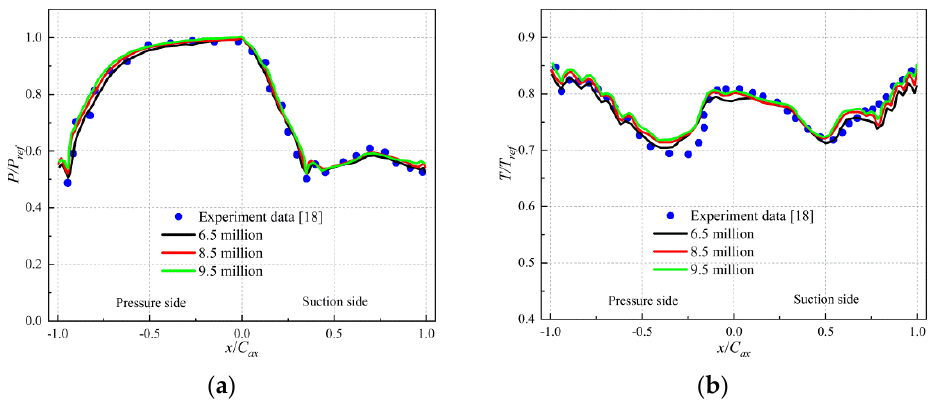
Figure 4. Grid independence test. ( a ) Pressure distribution; ( b ) temperature distribution.